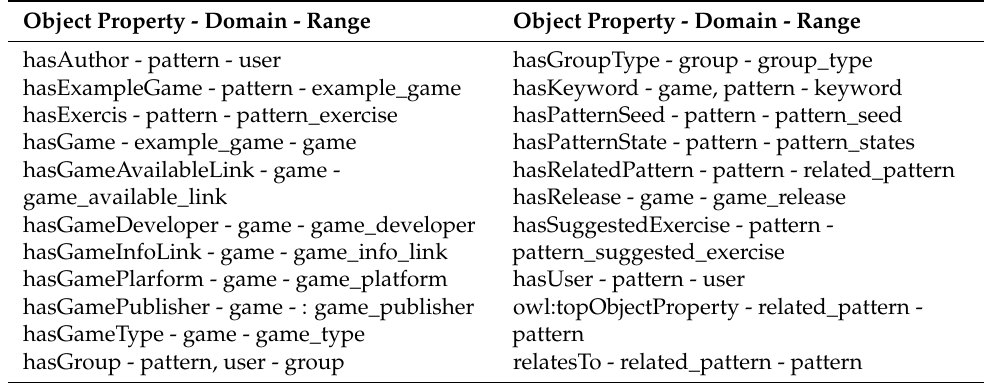
Table 2. Ontology object properties for representing a